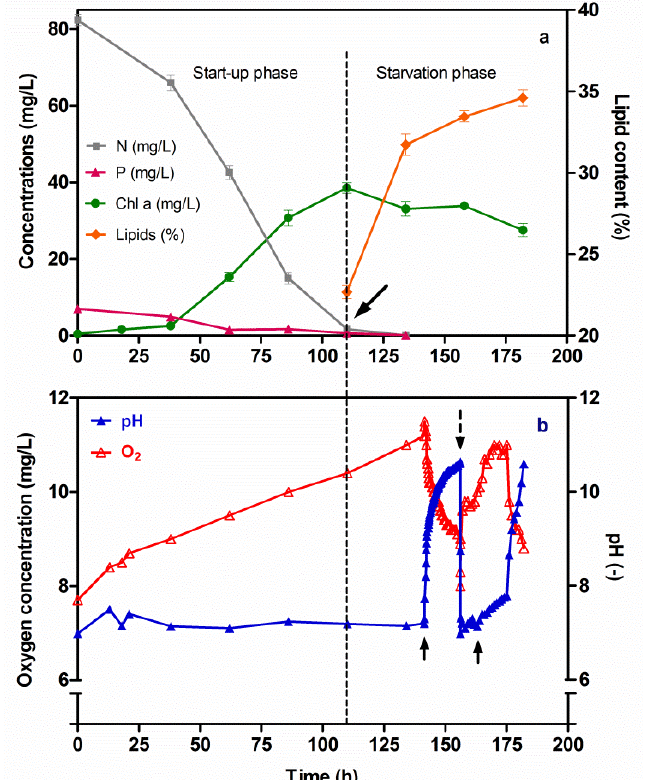
Figure 6. Changes in the Chl- a , N and P concentrations and lipid content versus time, under two sequential phases (Start-up and Starvation) of Chlorella vulgaris CCALA 896 growth ( a ); Changes in the pH and O versus time ( b ); The arrow in Figure ( a ) indicates 2 the beginning of the N and P starvation condition; the two arrows in Figure ( b ) indicate a halt into the inflow of CO in the culture; instead, the dotted row indicates the turn on to 2 the inflow of CO . A F PBR with a working volume of 550 mL was 2 G